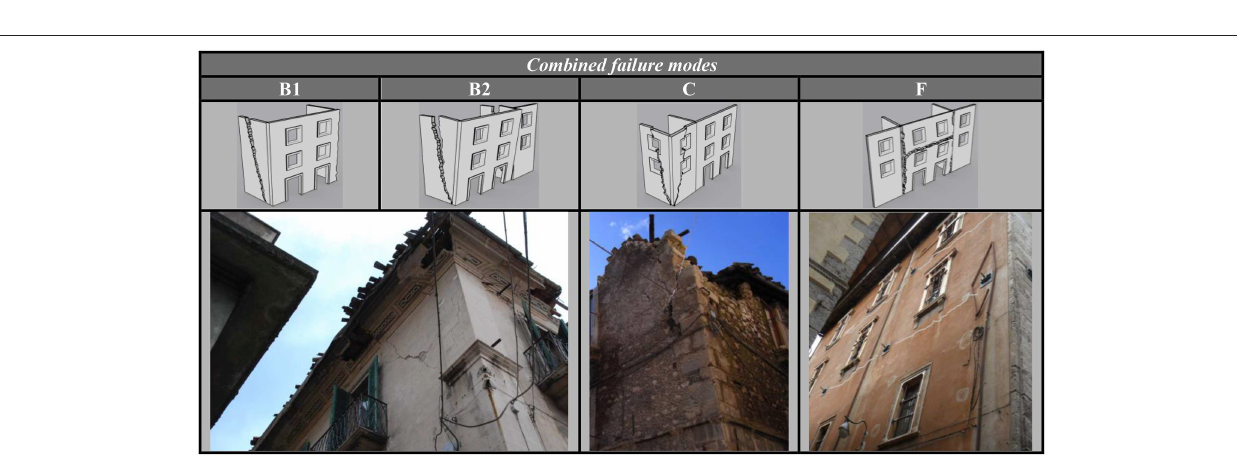
FIGURE 3 | On site identification of Combined failure modes, adapted from D’Ayala and Paganoni (2011).